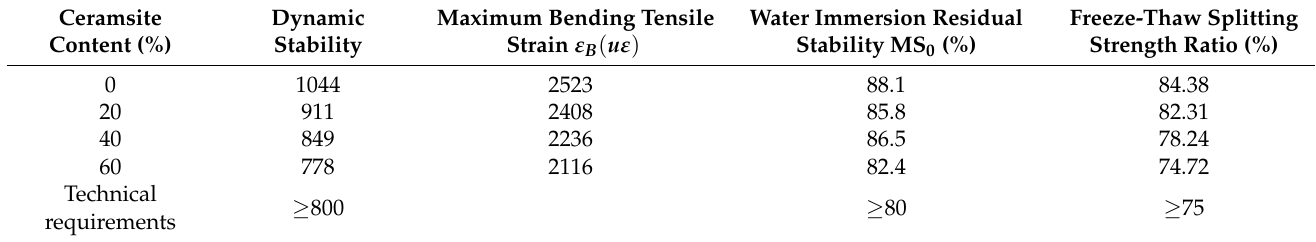
Table 4. Road performance of PCM asphalt mixtures.